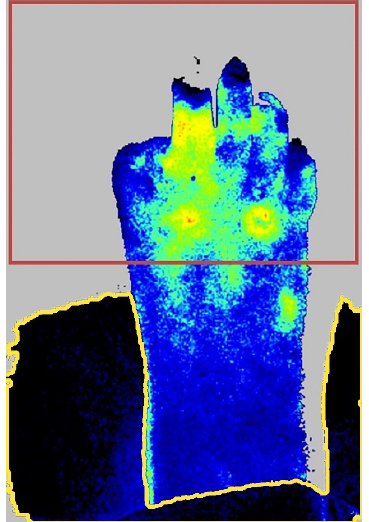
Figure 4. Example of a Laser Speckle Contrast Imaging recording with static artefacts. The red box defines the selected area of the image that was used for ROI tracking. Static artefacts (e.g., the examination bench and pressure band) are highlighted by the yellow outline and were ignored when calculating the transformation matrices.